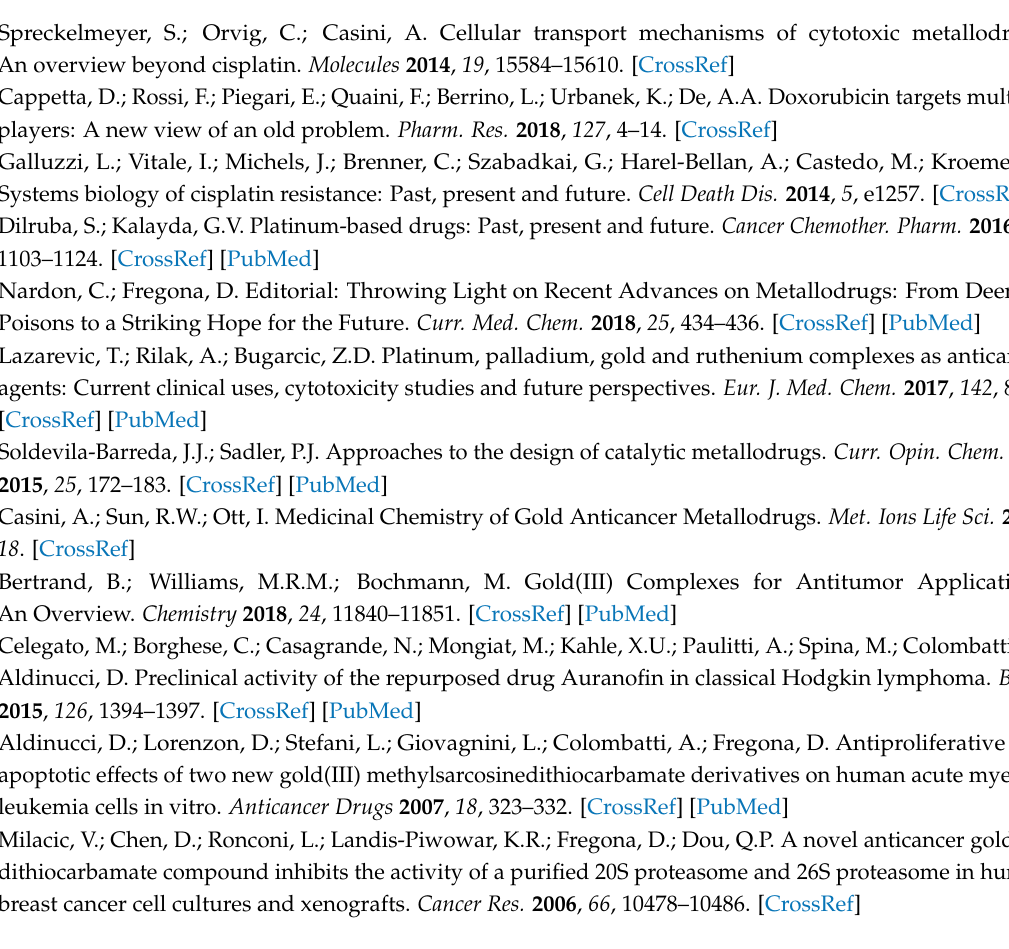
Figure S1: Voltammograms for the interaction of C1 with lysozyme in 0.1 M phosphate buffer (pH 6.8), Figure S2: Voltammograms for the interaction of C2 with lysozyme in 0.1 M phosphate buffer (pH 6.8), Figure S3: Voltammograms for the interaction of C3 with lysozyme in 0.1 M phosphate buffer (pH 6.8), Figure S4: Voltammograms for the interaction of compound C4 with lysozyme in 0.1 M phosphate buffer (pH 6.8), Figure S5: Voltammograms for the interaction of compound C5 with 0.5 mM tryptophan in 0.1 M phosphate buffer (pH 6.8), Figure S6: Voltammograms for the interaction of compound C6 with 0.5 mM tryptophan in 0.1 M phosphate buffer (pH 6.8), Figure S7: Voltammograms for the interaction of compound C7 with 0.5 mM tryptophan in 0.1 M phosphate buffer (pH 6.8); Figure S8: Voltammograms for the interaction of compound C8 with 0.5 mM tryptophan in 0.1 M phosphate buffer (pH 6.8); Figure S9: Voltammograms for the interaction of compound C1 with 0.5 mM guanine in 0.1 M phosphate buffer (pH 6.8), Figure S10: Voltammograms for the interaction of compound C5 with 0.5 mM guanine in 0.1 M phosphate buffer (pH 6.8), Figure S11: Uptake of selected gold(III) compounds by PC3 cells, Figure S12: Growth inhibition curves for C6 in PC3 prostate cancer cells and adipose-derived stromal cells (ADSCs). Table S1: Voltammetry peak potential (mV) of 100 µ M compounds ( C1 – C4 ) with 1–10 µ M lysozyme, Table S2: Voltammetry peak potential (mV) of 0.5 mM tryptophan with 10–100 µ M compounds ( C5 – C8 ), Table S3: Voltammetry peak potential (mV) of 0.5 mM guanine with 10-100 µ M compounds C1 and C5